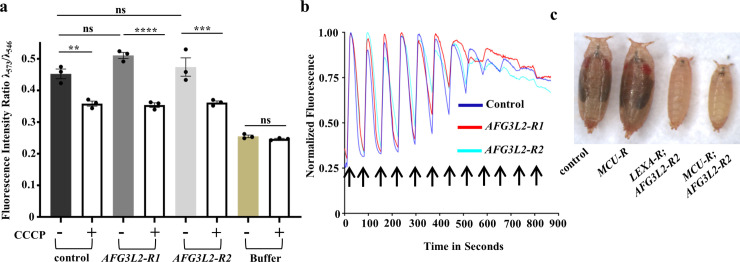
Mitochondrial membrane potential and calcium uptake are unaffected in AFG3L2-deficient animals.a. Mitochondrial membrane potential was examined using mitochondria from control (UAS-LUCIFERASE RNAi/da-Gal4) and AFG3L2-deficient (UAS-AFG3L2-R1 RNAi; da-Gal4 and UAS-AFG3L2-R2 RNAi/da-Gal4) pupae. Relative membrane potential was determined by measuring the fluorescence intensity ratio of Tetramethylrhodamine methyl ester perchlorate at 590nm using excitation wavelengths of 546 and 573nm (see materials and methods for details). The CCCP (0.5 mM) was added to samples following the fluorescence scan to normalize for background fluorescence (**p < 0.01, ***p < 0.0005, ****p < 0.0001 by one way ANOVA Tukey's test for multiple comparison). b. Calcium uptake capacity of mitochondria isolated from control (UAS-LUCIFERASE RNAi/da-Gal4) and AFG3L2-deficient (UAS-AFG3L2-R1 RNAi; da-Gal4 and UAS-AFG3L2-R2 RNAi/da-Gal4) pupae was determined using fluorescent dye Oregon green BAPTA 6F. Arrows represent pulses of 50 μM CaCl2 given at 1 minute intervals. Experiments were performed using two independent biological replicates and a representative trace is shown. c. Size comparison of control pupae (UAS-LUCIFERASE RNAi/da-Gal4), pupae expressing an RNAi targeting MCU: MCU-R (UAS-MCU RNAi; da-Gal4), AFG3L2-deficient pupae: LEXA-R; AFG3L2-R2 (UAS-LEXA RNAi; UAS-AFG3L2-R2 RNAi/da-Gal4) and AFG3L2-deficient pupae expressing an RNAi targeting MCU: MCU-R; AFG3L2-R2 (UAS-MCU RNAi; UAS-AFG3L2-R2 RNAi/da-Gal4). To account for the possible titration of Gal4 protein in the presence of two UAS transgenes, we compared MCU-R; AFG3L2-R2 to AFG3L2-R2 expressing the RNAi against the exogenous LEXA sequence (LEXA-R). Pupae in images were collected 9 days after egg hatching.